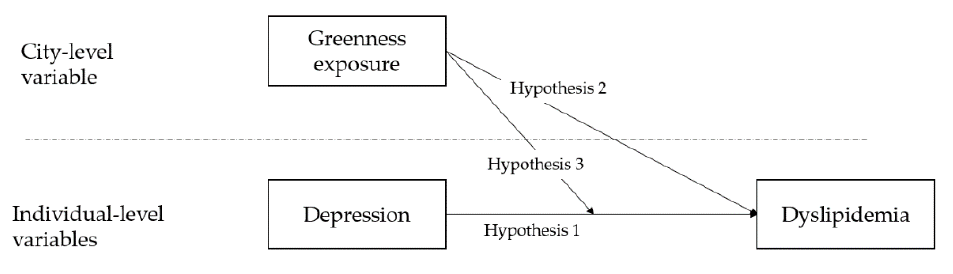
Figure 1. Research